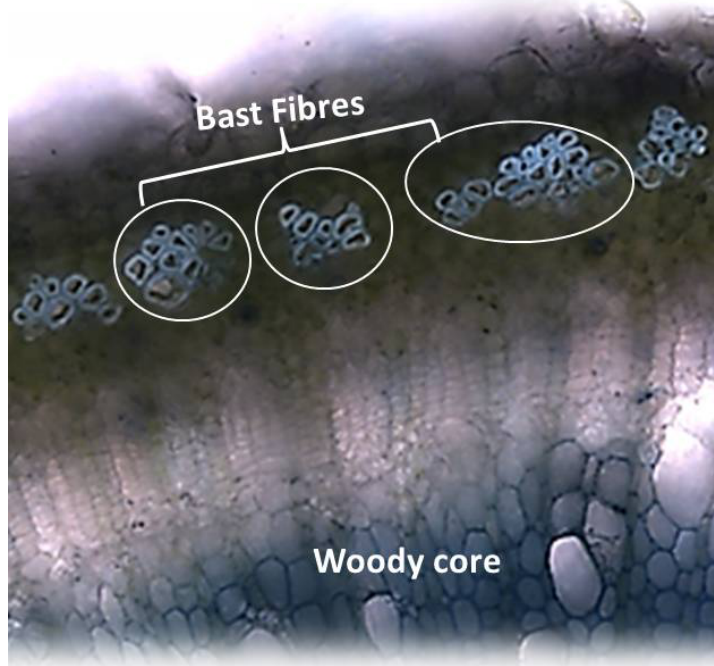
Figure 1. Cross section of C. sativa stem (Toluidine Blue staining), showing the bast fibres surrounding the woody